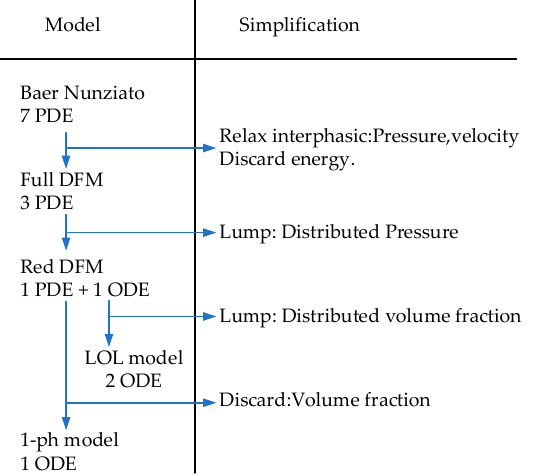
Figure 1. Relation between the models [11]. PDE: partial differential equation; DFM: drift flow model; and ODE: ordinary differential equation.